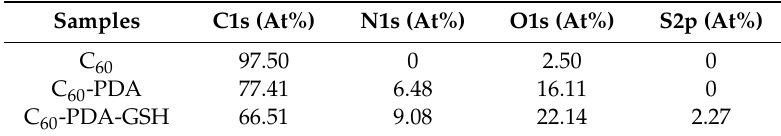
Table 1. Element contents (%) of C 60 , C 60 -PDA, and C 60 -PDA-GSH based on the XPS